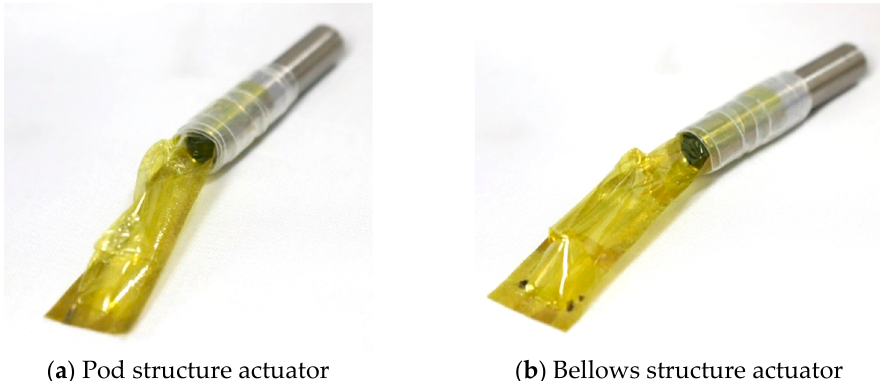
Figure 14. Fabricated actuators: ( a ) photograph of pod structure actuator; ( b ) photograph of bel- lows structure actuator.